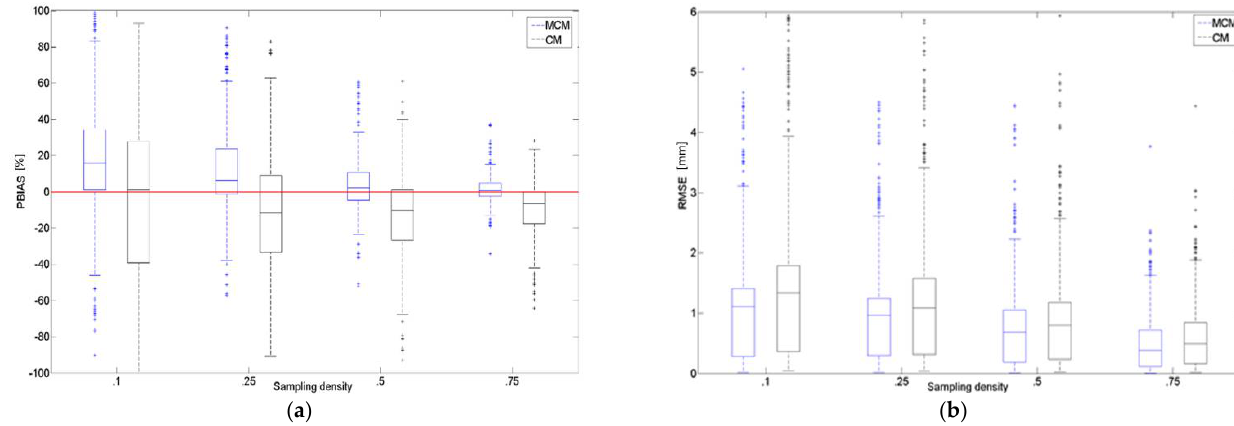
Figure 8. Ensemble of PBIAS ( a ) and RMSE ( b ), varying with densities. The blue lines indicate MCM, while the black ones indicate CM.